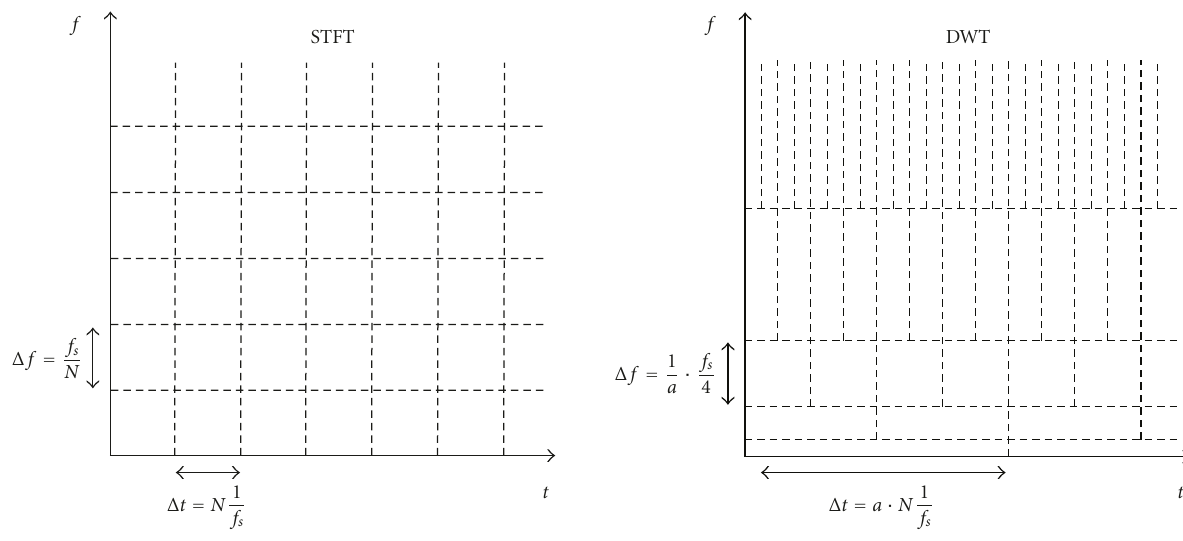
Figure 1: Comparison of time and frequency resolutions ( f s : sampling frequency; N : number of sample points per analysis